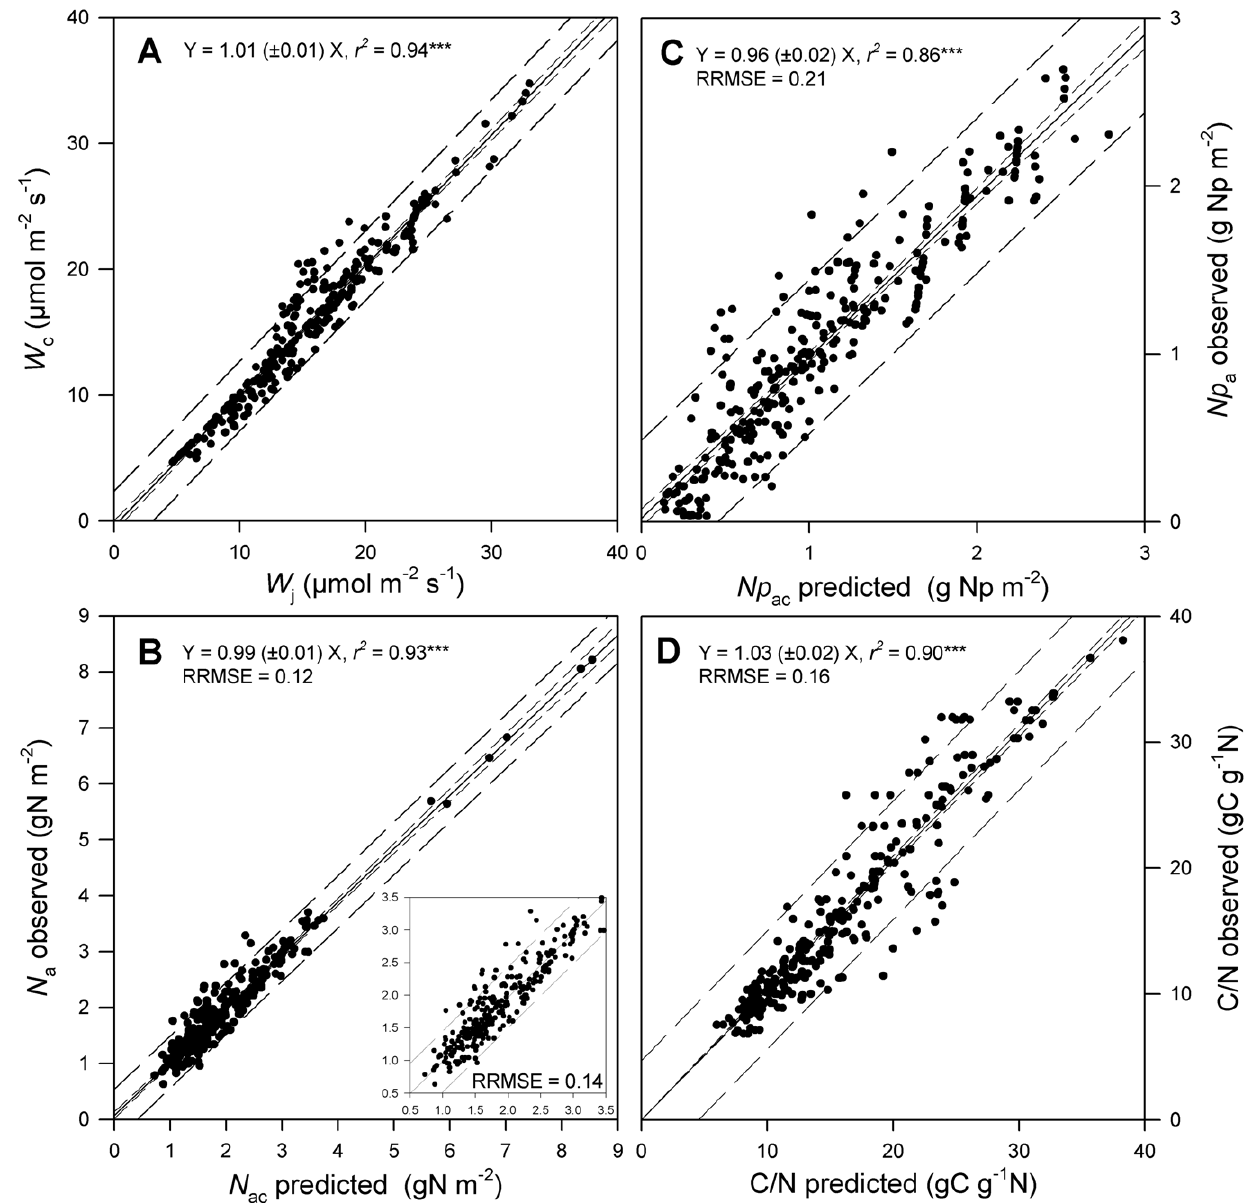
Figure 1. Tests of the coordination hypothesis using experimental values of leaf photosynthetic traits ( Vc max , J max , J fac , k 3 and SLA ). A) Relationship between the predicted rates of RuBP carboxylation/oxygenation ( W c ) and RuBP regeneration ( W j ) under plant growth conditions. B) Relationship between predicted ( N ac ) and observed ( N a ) leaf N content. N a was calculated as the sum of the leaf photosynthetic and structural N contents. Leaf photosynthetic N content was predicted using Eqn 2 with the species-specific parameters k 3 and J fac . C) Relationship between predicted ( Np ac ) and observed ( Np a ) photosynthetic leaf N content. D) Relationship between predicted and observed leaf C/N ratio. A common leaf structural N content was used ( fns =0.012 gN g 2 1 DM). Solid lines are the regressions. Short-dashed and long-dashed lines indicate the confidence (at 95%) and prediction intervals, respectively. The insert in Fig. 1B shows the same relationship without the very high observed N a values for the PFT1. ***, P ,